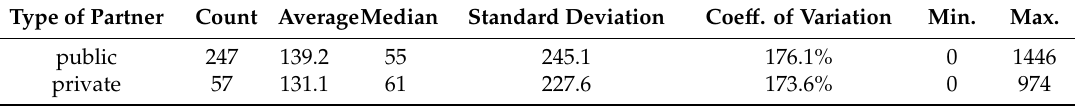
Figure 7. The percentage distribution of the analyzed events across specific levels as per the number of meetings, depending on the type of supporting partner. Source: own study. Table 5. Basic descriptive statistics for the number of meetings, depending on the type of supporting partner. Type of Partner